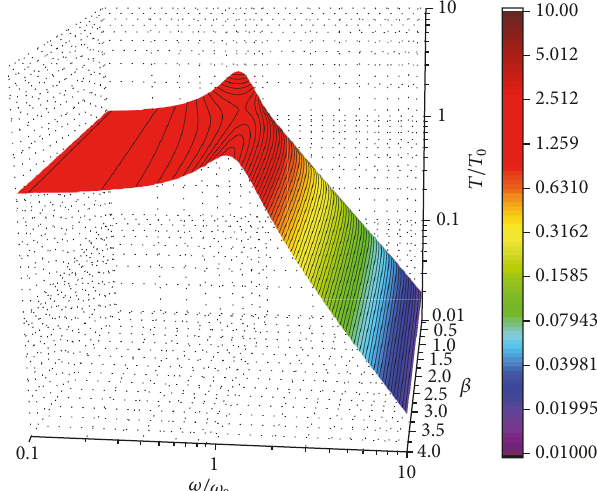
Figure 49: Transmissibility surface ( 𝛼 = 2, 𝛽 =